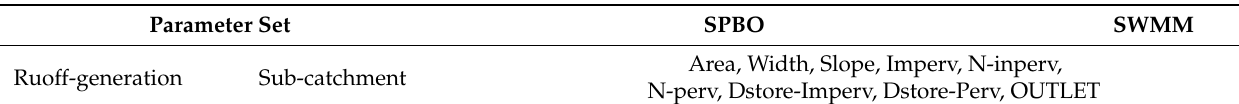
Table A1. Model parameter